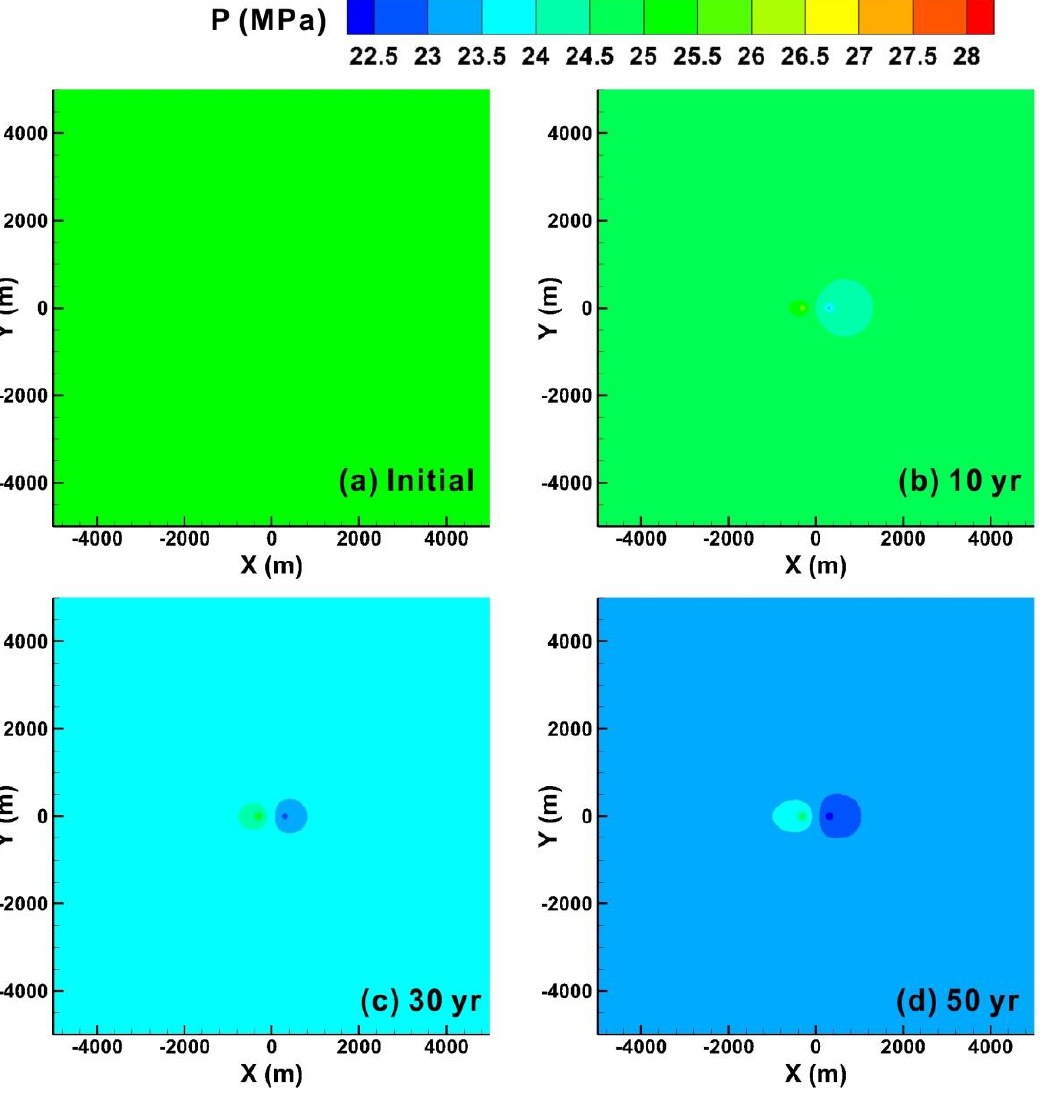
Figure 2. The reservoir pressure distribution at different times with the scheme of the same mass flow rate for injection and production.